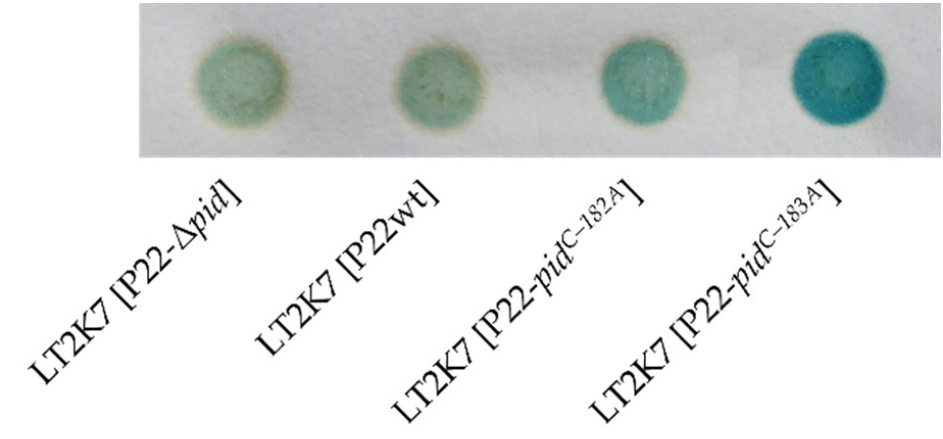
Figure 3. Pid/ dgo interaction is absent during lysogeny. Spots of indicated LT2K7 (i.e., LT2 dgoT:: Mu d K) lysogens grown on LB X-Gal in which blue coloration reports on LacZ activity, and thus dgo derepression.